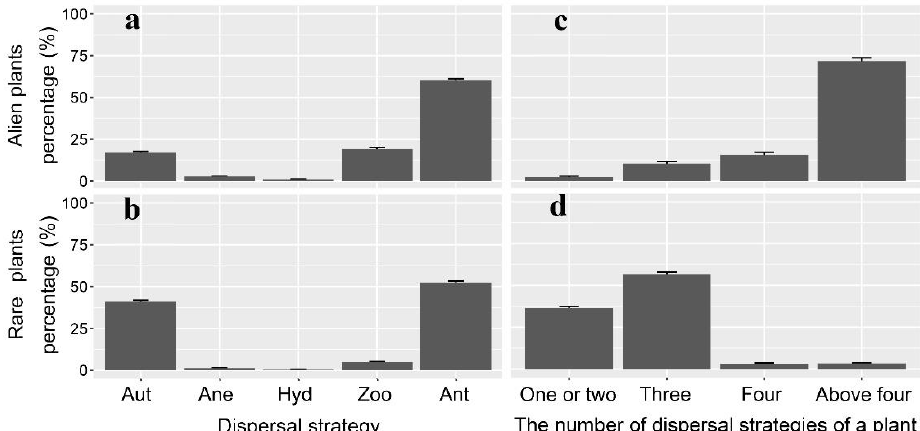
Figure 1. Percentage of dispersal strategies and the number of dispersal strategies of a plant. Percentage of dispersal strategy of alien plants ( a ) and rare plants ( b ); percentage of the number of dispersal strategies of a plant of alien plants ( c ) and rare plants ( d ). Aut, autochory; Ane, anemochory; Hyd, hydrochory; Zoo, zoochory; Ant, anthropochory; One or two, one or two modes; Three, three modes; Four, four modes; Above three, more than four modes. Error bars represent standard error. Higher proportion of alien species have multiple dispersal modes. For example, most alien species (71.7%) use more than four dispersal strategies (Figure 1c), while the vast majority of rare plants use up to three dispersal strategies (92.3%) (Figure 1d). Spores or seeds (72.9%) were the main reproduction modes of alien plants (Figure 2a), rare plants (Figure 2b).